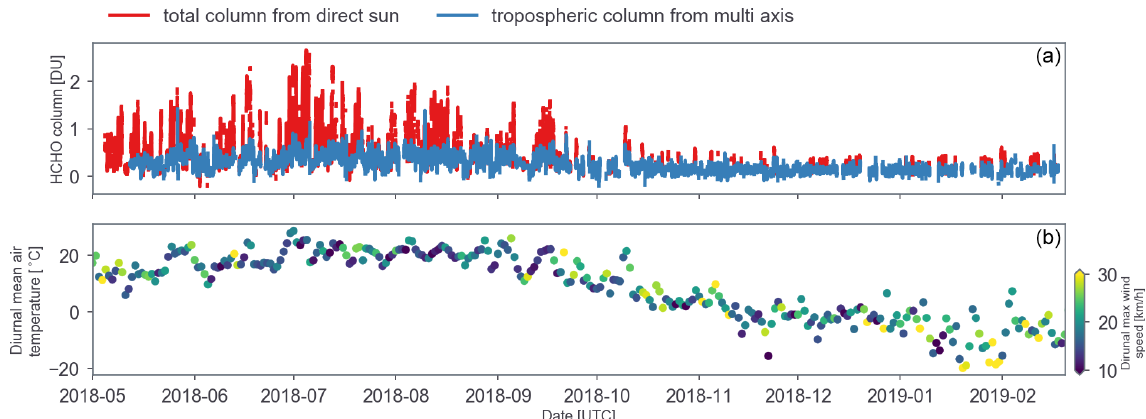
Figure 2. (a) HCHO direct-sun total columns (red) and multi-axis tropospheric columns (blue) as retrieved from Pandora 108 near Toronto, Canada, for a 10-month time series in 2018–2019. The significant overestimation of direct-sun HCHO in summer months is evident. Ref- erence spectrum for direct-sun DOAS analysis was collected during a cold winter day. Multi-axis analysis was done with zenith reference spectra measured within 2–3min of the rest of the spectra. (b) Mean diurnal temperature and maximum wind speed measured near Pandora